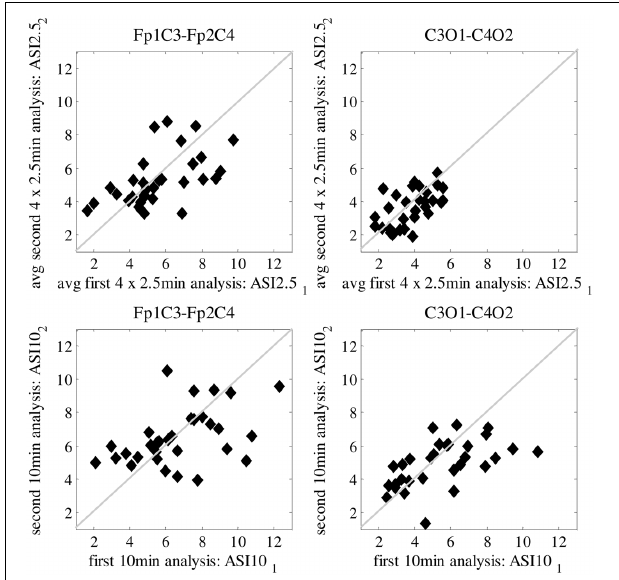
FIGURE 2 | Difference in mean-squared difference (MSD) between two analyzed periods of 10-min EEG, every dot representing a different patient. Results are shown for Frontal-Centro (Fp-C) and Centro-Occipital (C-O) derivations for different analyzing window lengths (2.5/10min). Best result with lowest MSD is shown in the upper right plot, obtained for average ASI values over 4 × 2 . 5min analysis on C-O derivations.